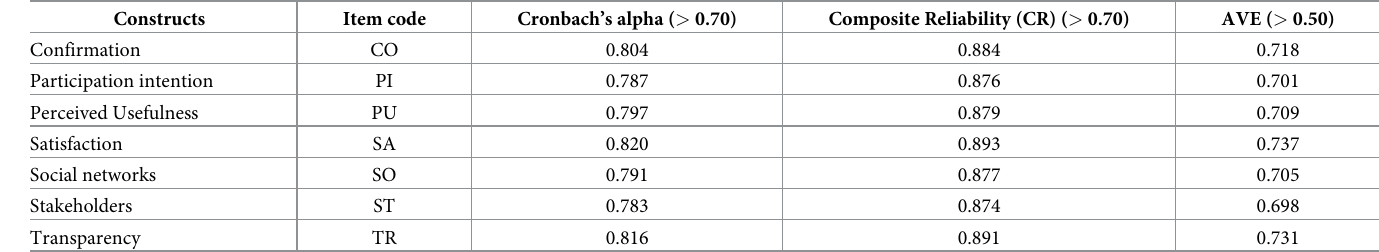
Table 2. Construct reliability and validity.